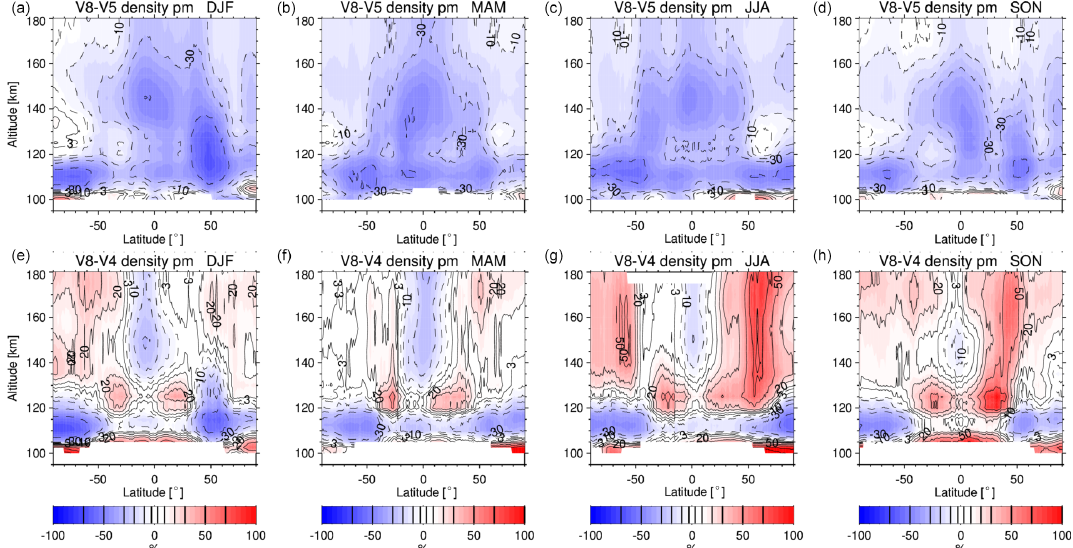
Figure 15. As Fig. 14 but for afternoon